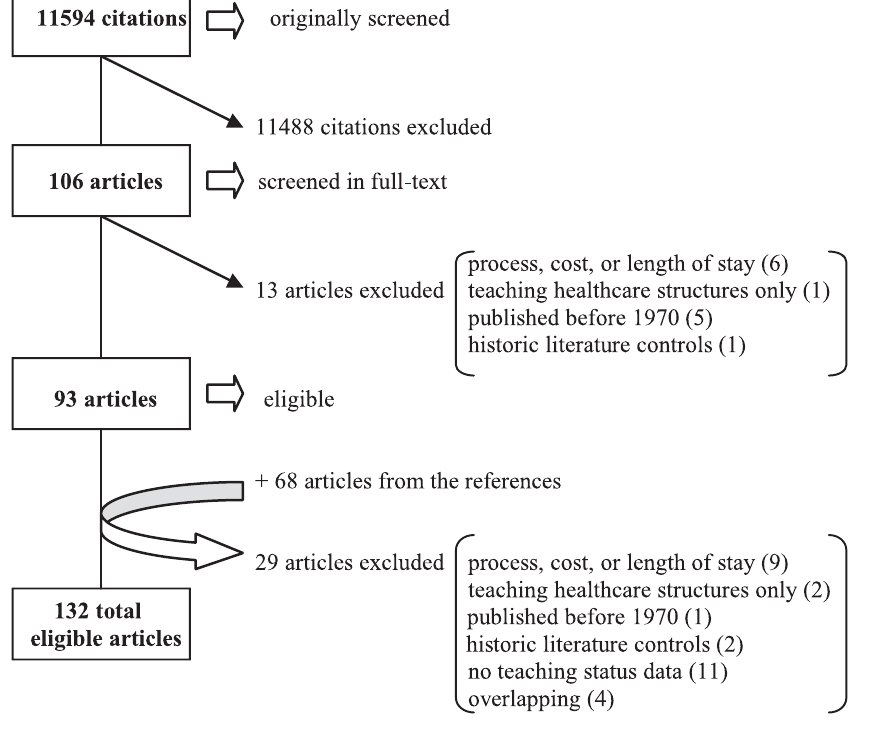
Figure 1. Flow Figure for Screened, Included, and Excluded Articles DOI: